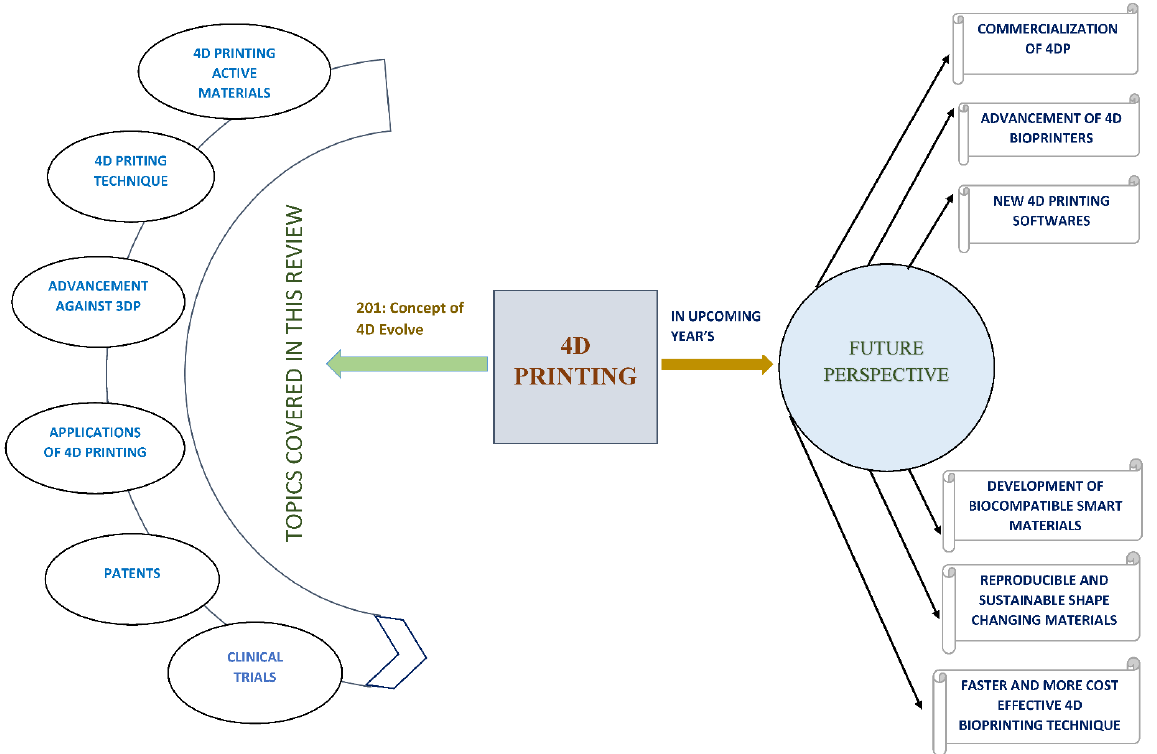
Figure 6. Summary of future perspective of 4DP with a focus on the methods that can be adopted